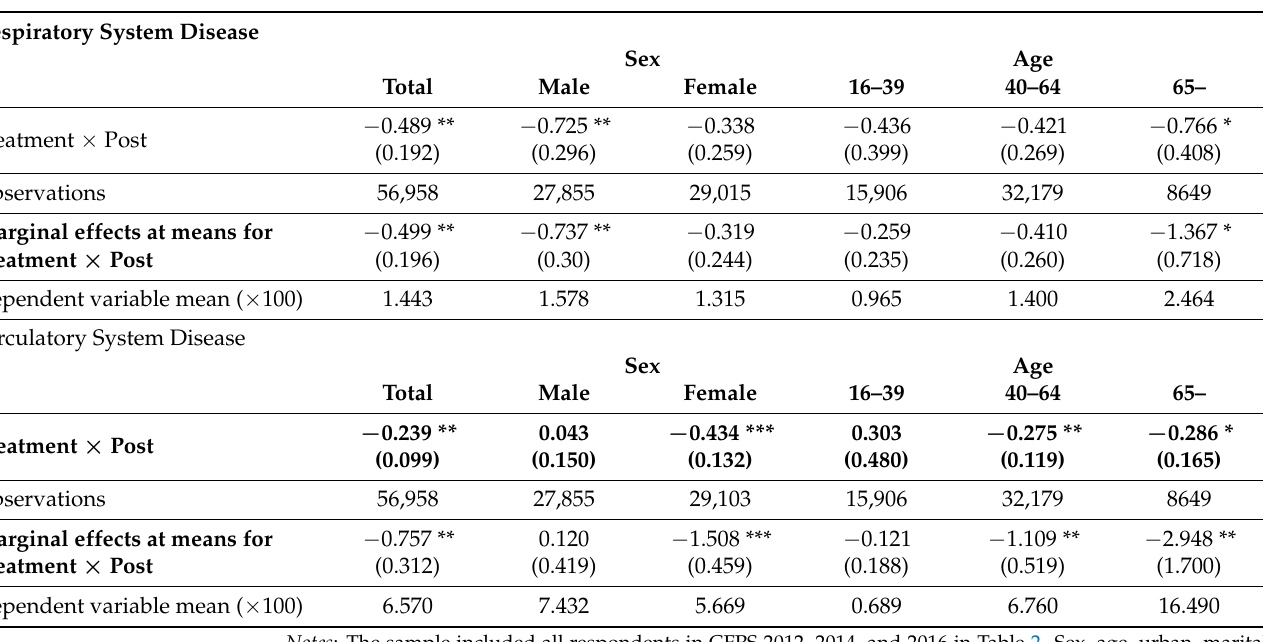
Table 4. Logit estimates: effects of APPCAP on chronic conditions, by sex and age